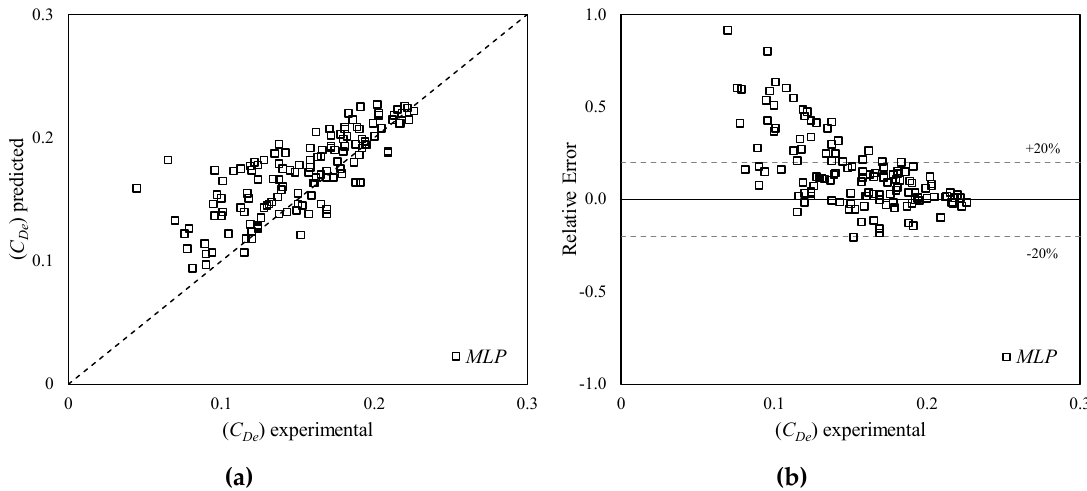
Figure 8. Model 1, MLP algorithm, ( a ) predicted versus experimental results, and ( b ) relative error versus experimental results.